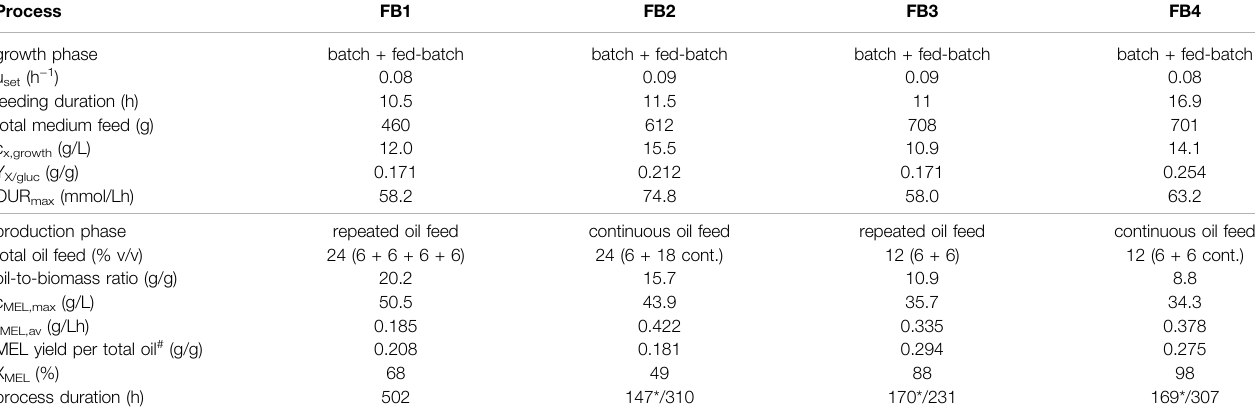
TABLE 3 | Process values for fermentations with combined batch and fed-batch growth and repeated or continuous oil feeding.